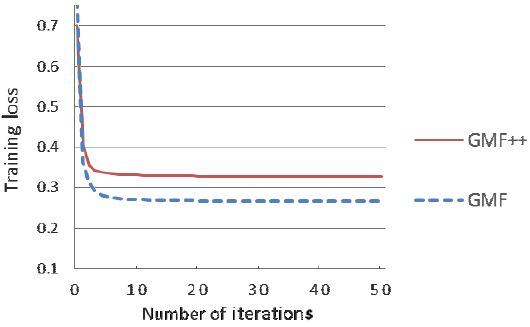
Fig. 6 Training loss w.r.t. number of iterations.